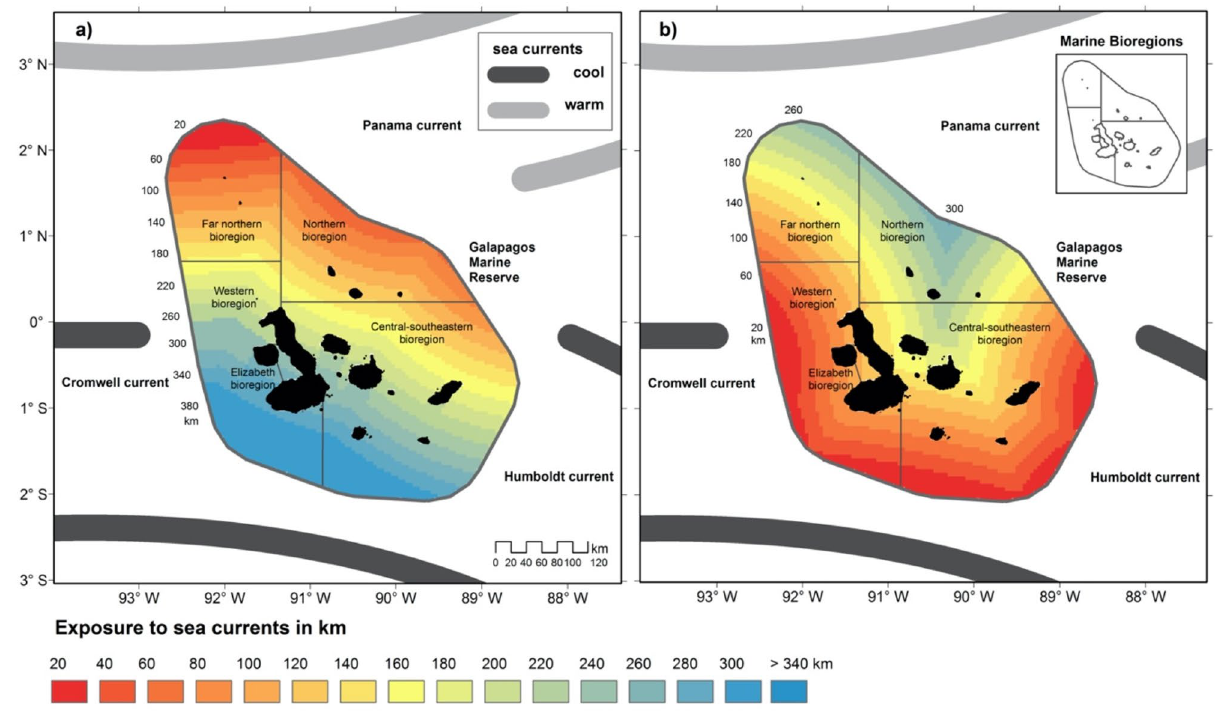
Figure 6. Annual exposure of the Galapagos Marine Reserve (GRM) to warm ( a ), and cool ( b ), currents. Black lines represent the five marine bioregions of the GMR as defined by Edgar et al. 26